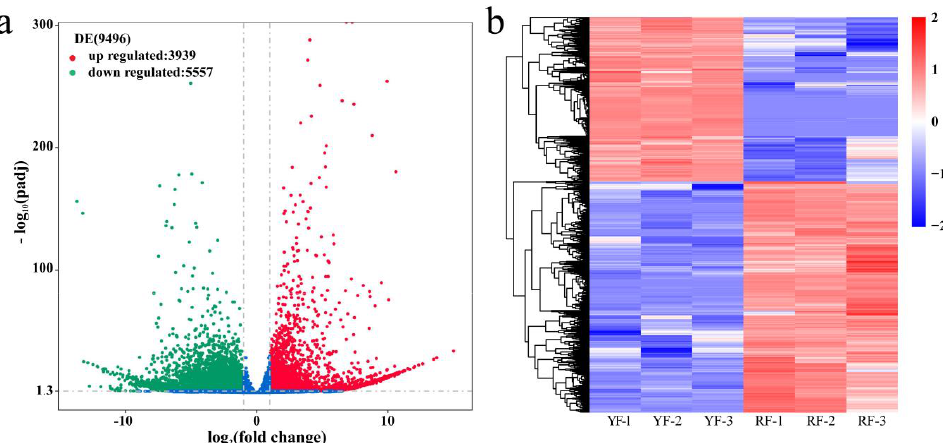
Figure 3. Analysis of differentially expressed genes (DEGs) in Cerasus humilis. ( a ) Comparison of the gene transcription profile of the YF and RF libraries. The red dots represent the up-regulated genes, and the green dots represent the down-regulated genes. ( b ) Heat map of DEGs based on hierarchical clustering analysis.